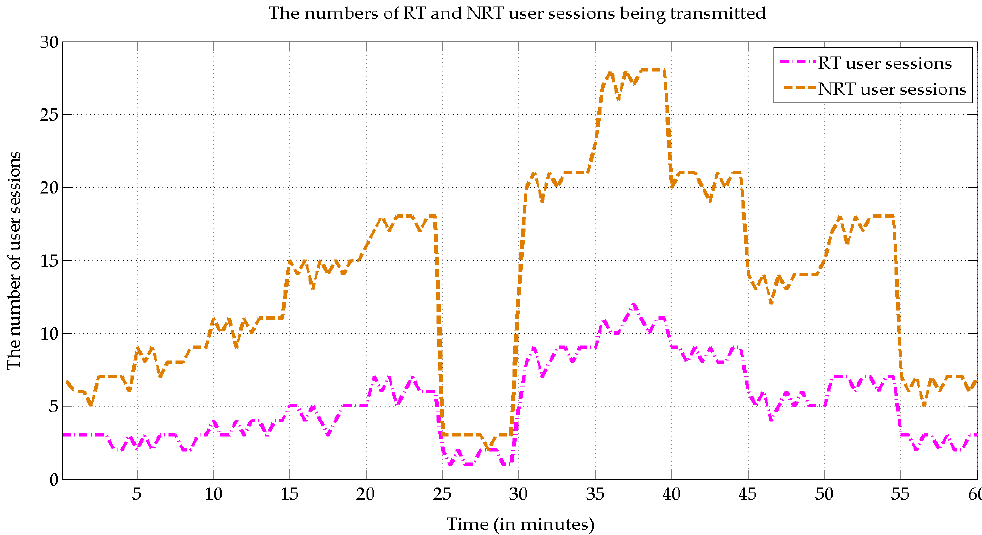
Figure 4. The numbers of RT and NRT user sessions over time.